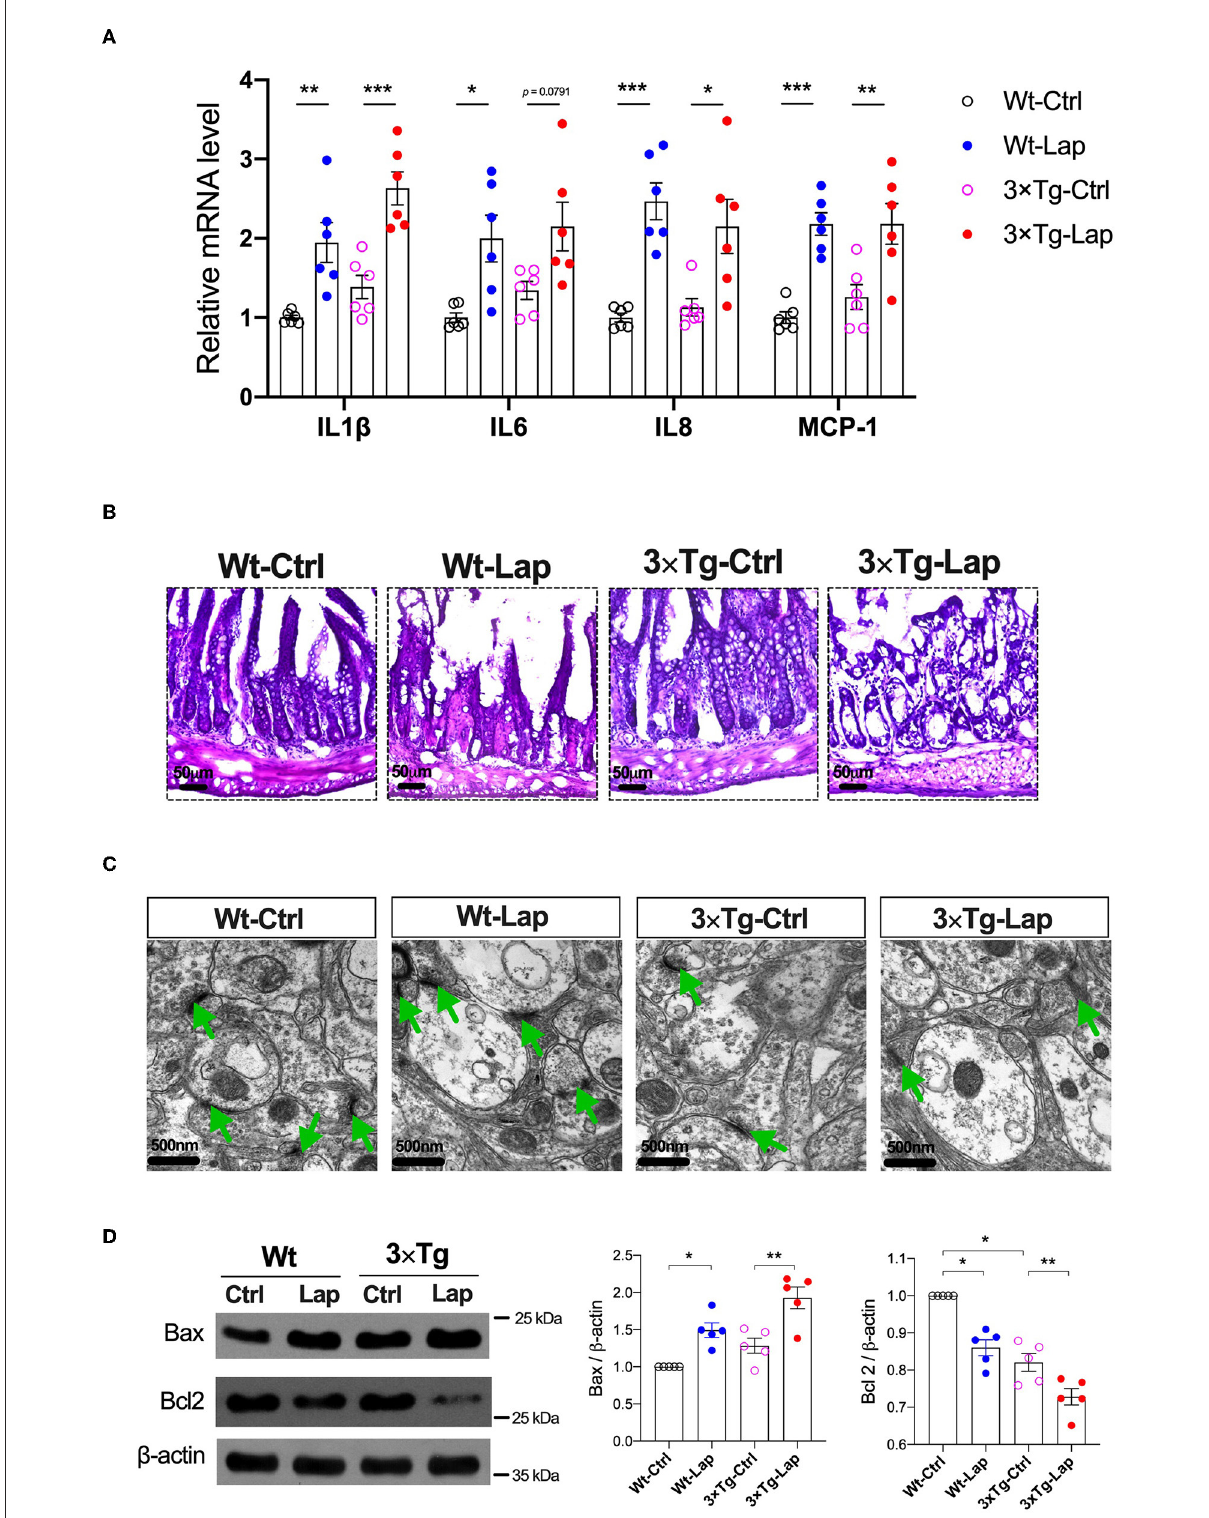
FIGURE3 Laparotomy caused similar inflammatory responses in the periphery and hippocampus in both wild-type and 3 × Tg AD mice. (A) Relative mRNA level of pro-inflammatory cytokines at postoperative 24h in the hippocampi. IL-1 β : F (3,20) = 15.60, P < 0.0001; IL-6: F (3,20) = 5.97, P = 0.0044; IL-8: F (3,20) = 11.57, P = 0.0001; MCP-1: F (3,20) = 13.18, P < 0.0001. (B) Morphological changes of acini and base of the intestine in postoperative